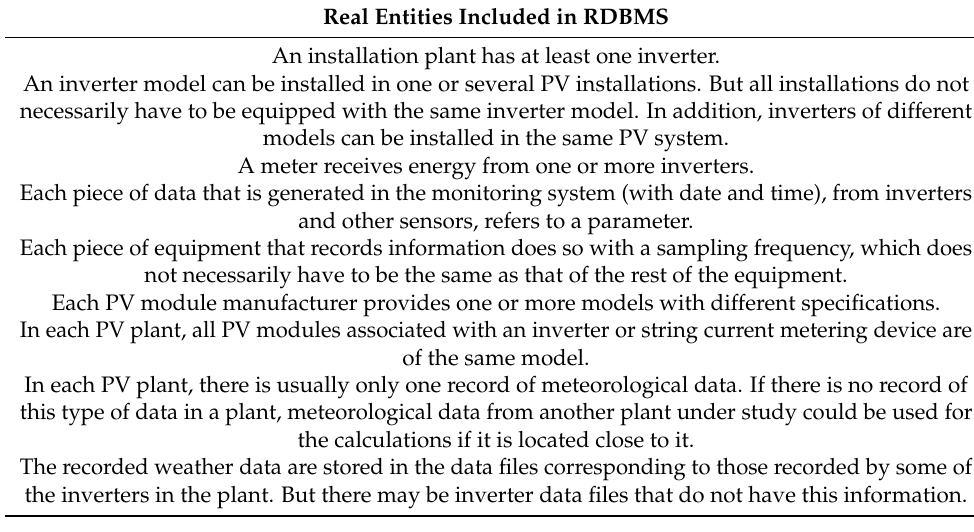
Table 3. Established relationships between real system entities included in the RDBMS. Real Entities Included in